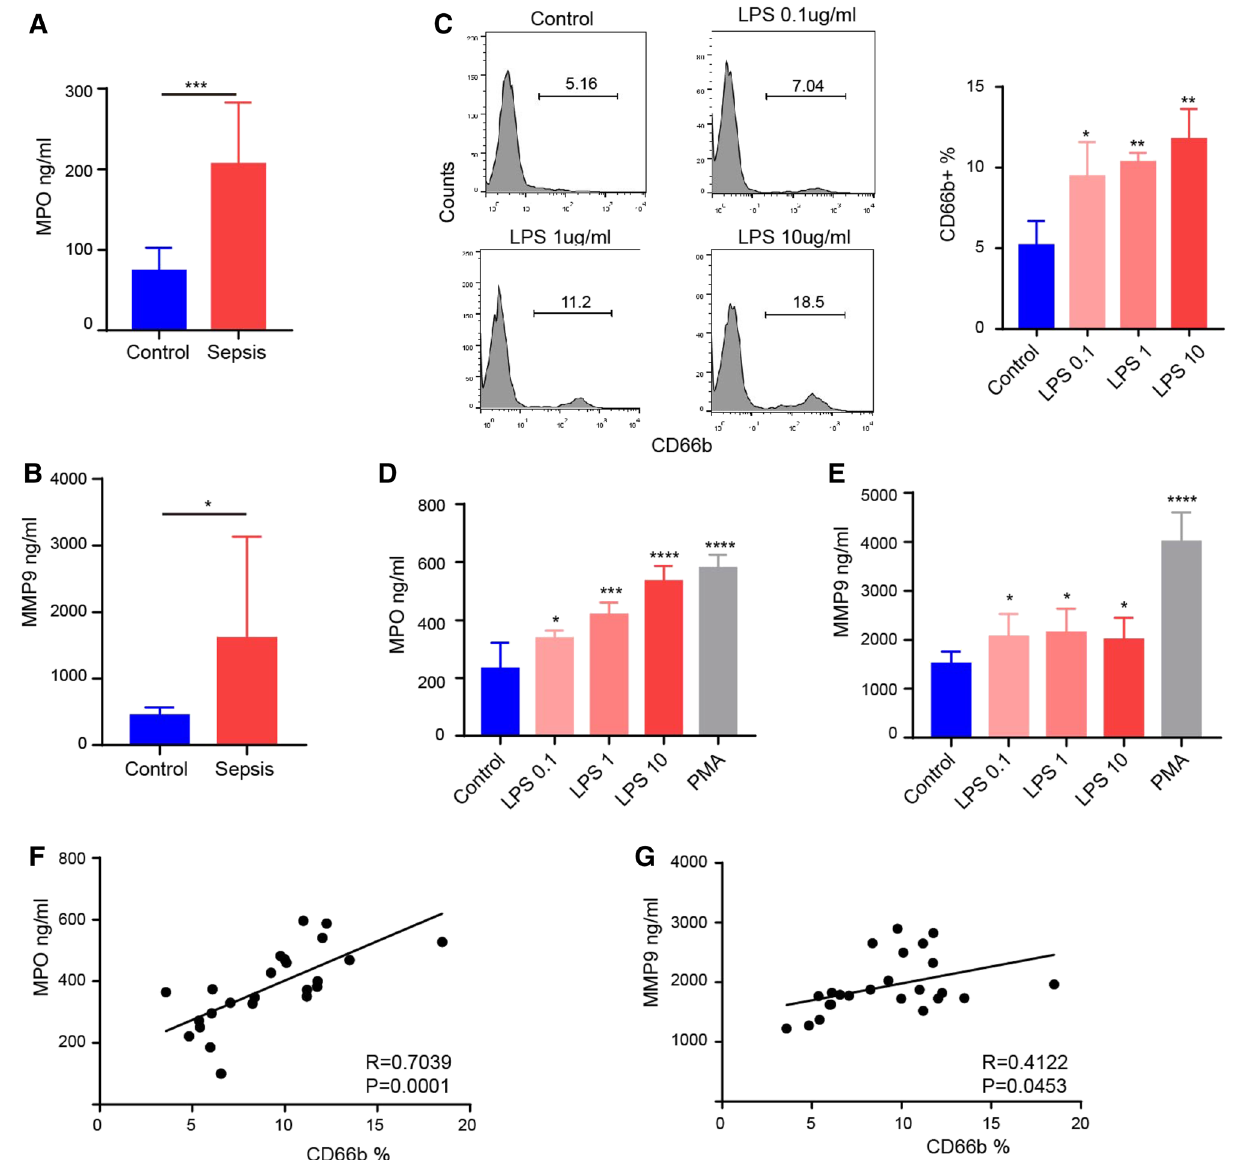
Figure 3. Degranulation is associated with the production of LDNs. ( A ) MPO concentrations in healthy controls and sepsis patients. ( B ) MMP9 concentrations in healthy controls and sepsis patients. ( C ) Changes of LDNs in PBMC layer after stimulation of neutrophils with various concentrations of LPS. ( D ) MPO concentration in the supernatants of neutrophils stimulated by LPS or PMA. ( E ) MMP9 concentration in the supernatants of neutrophils stimulated by LPS or PMA. ( F , G ) Correlation analysis of LDNs ratio and degranulation